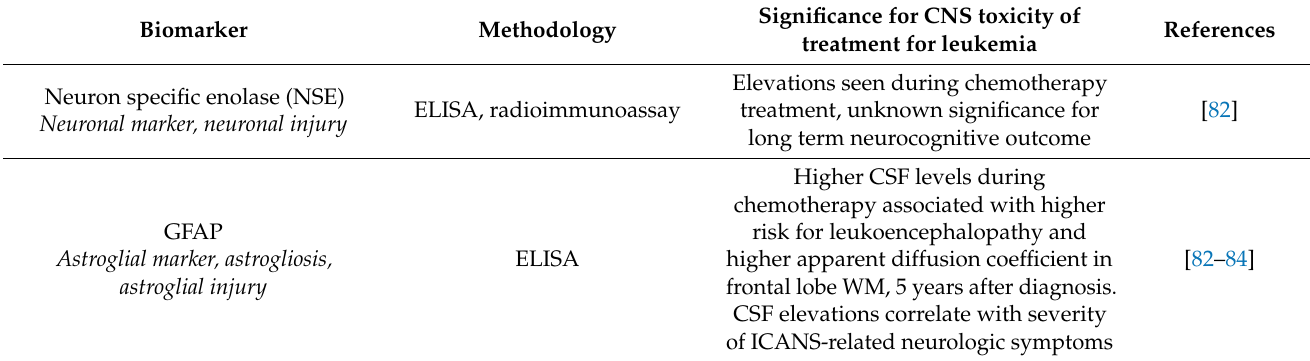
Table 2. CSF biomarkers reflecting CNS toxicity of treatment in childhood leukemia.